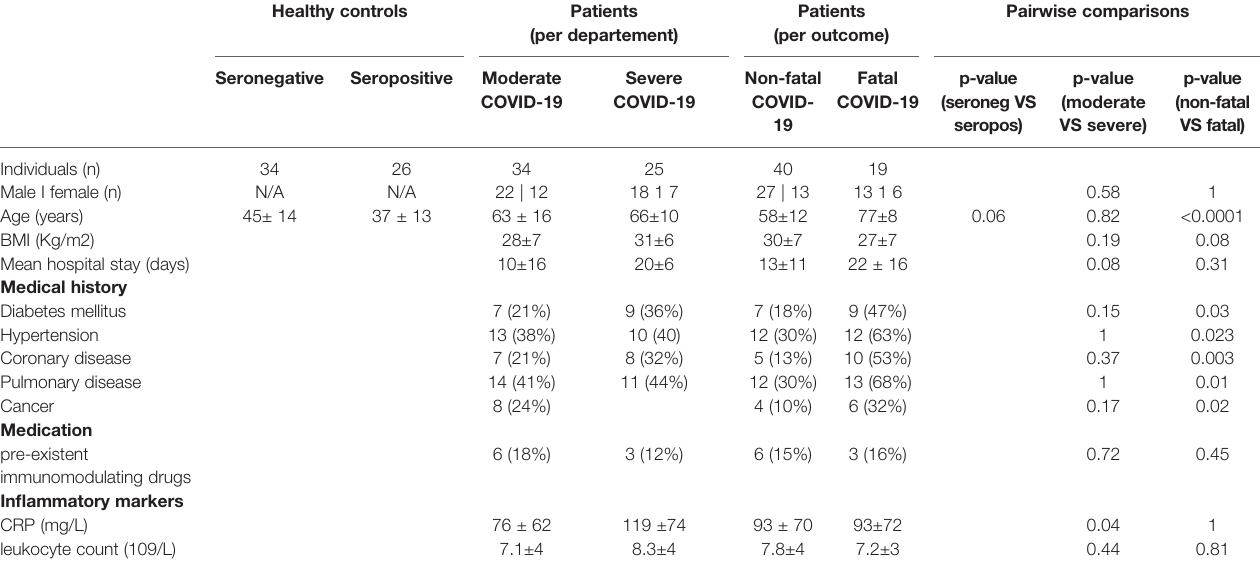
TABLE 1 | Clinical characteristics of patients with COVID-19 disease.